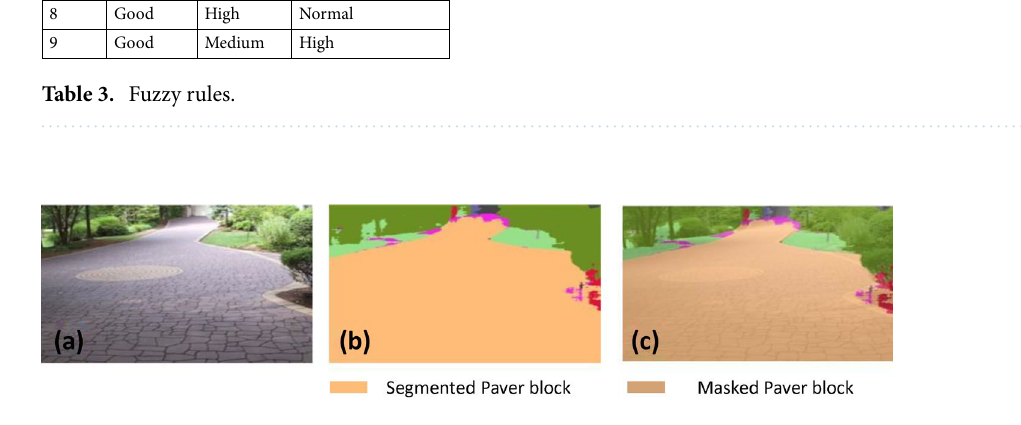
Figure 8. Offline results: paver block.